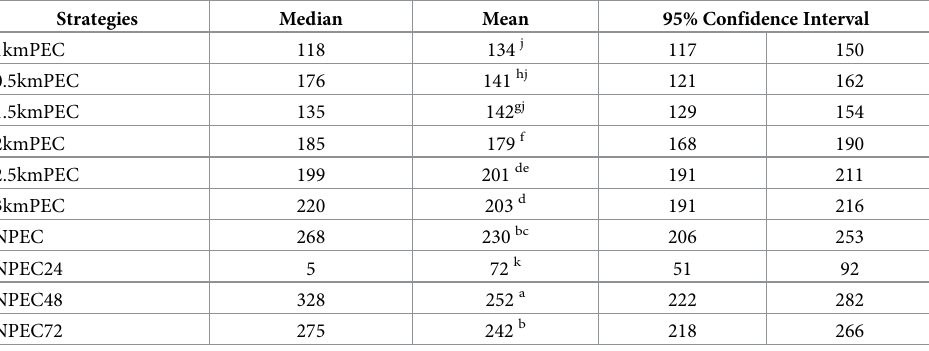
Table 3. Comparison of the number of infected poultry farms estimated for the different control strategies. Strategies Median Mean 95% Confidence Interval 1kmPEC 8 11 e 9 13 0.5kmPEC 28 28 f 23 32 1.5kmPEC 2.5kmPEC 3kmPEC NPEC 268 230 bc 206 253 NPEC24 5 72 defgh 51 92 NPEC48 328 252 a 222 282 NPEC72 275 242 b 218 266 Means with different superscripts in each column were statistically different.